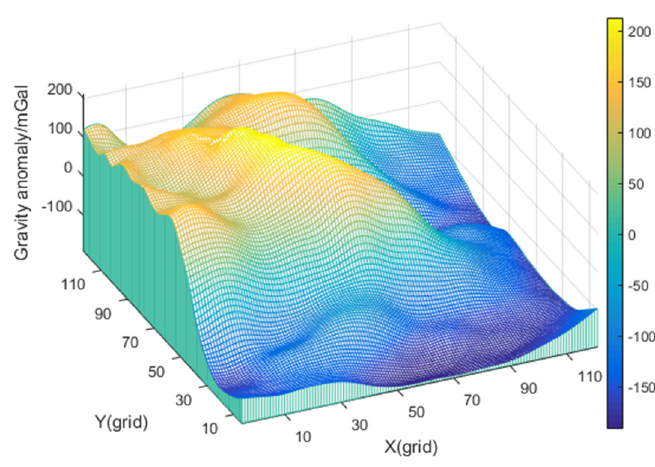
Figure 6. The distribution of gravity field of track 2.